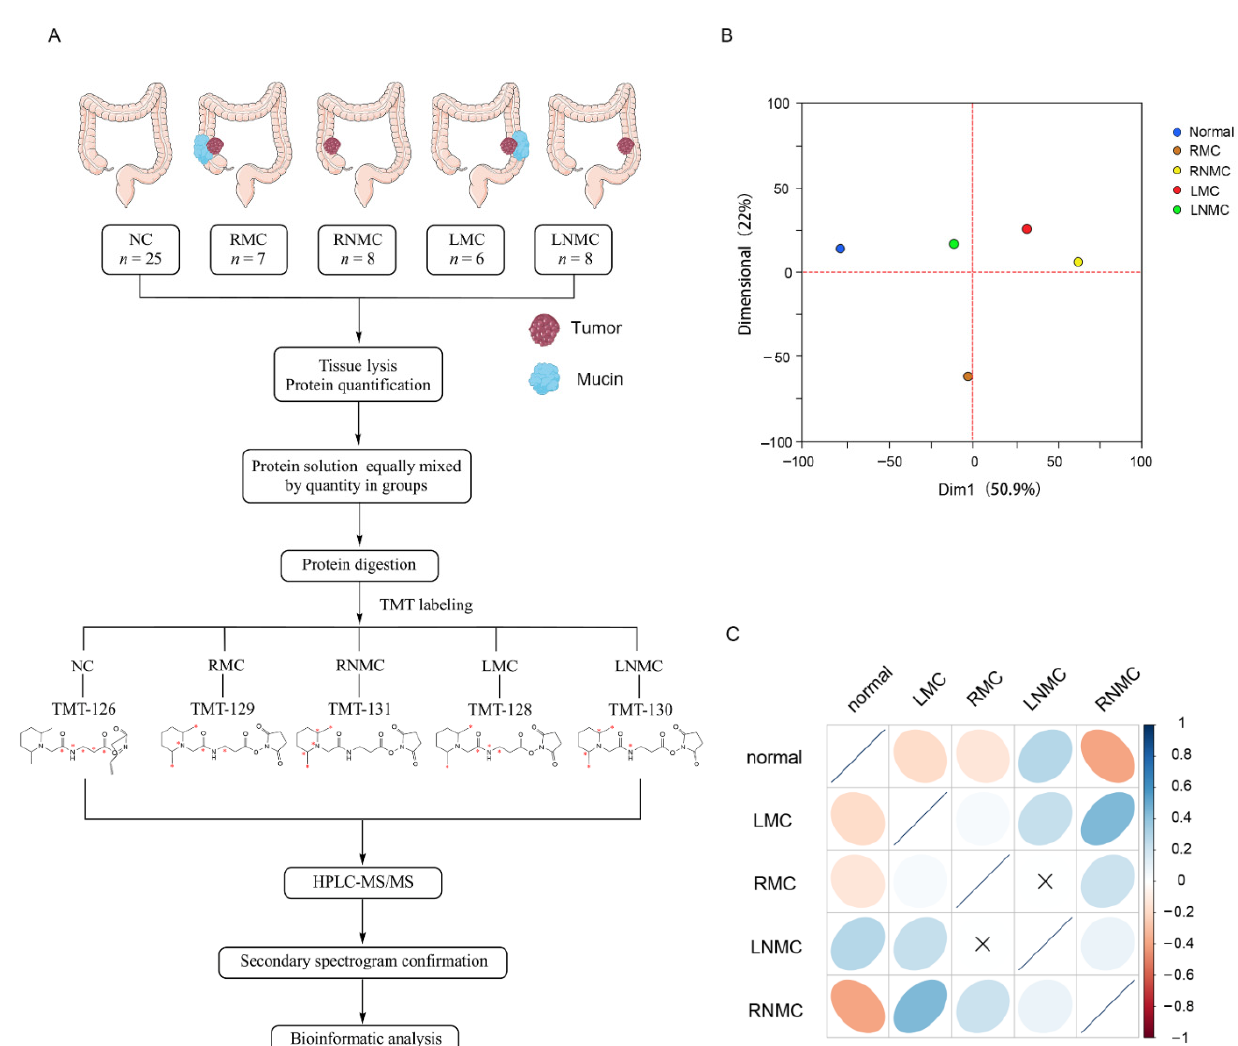
Figure 1. Quantitative characteristics of protein profiles. ( A ) Experimental workflow. ( B ) Principal component analysis of protein profiles of normal, RMC, RNMC, LMC, and LNMC. ( C ) Correlation matrix showing the protein abundance correlations between normal, RMC, RNMC, LMC, and